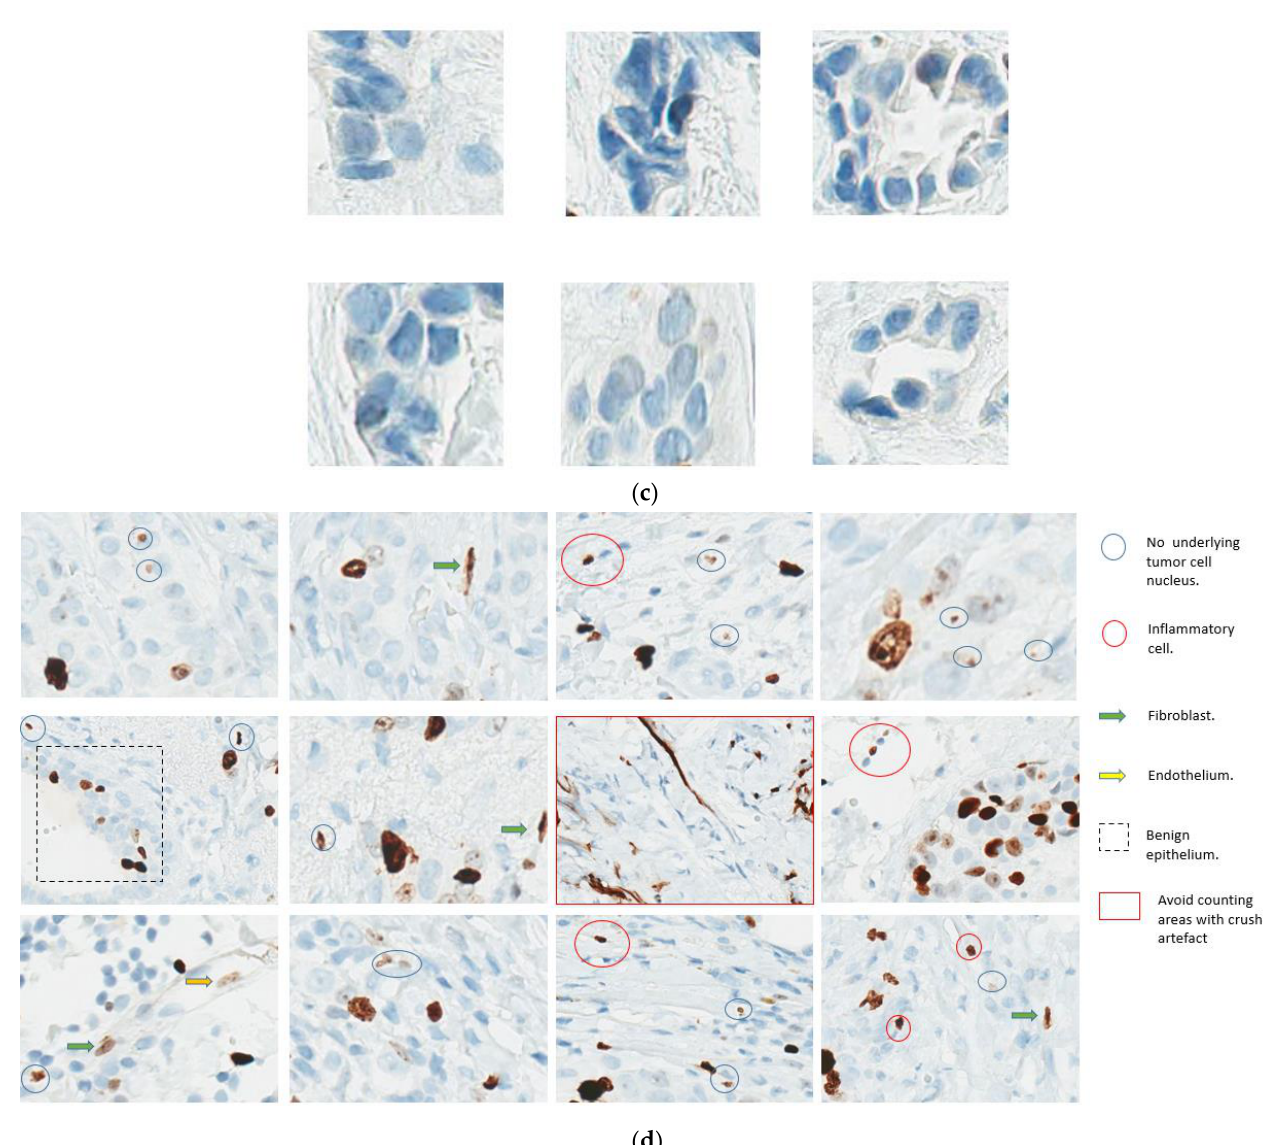
Figure 4. ( a ) . Ki67 Positive nuclei; ( b ): Ki67 Light brown positive nuclei; ( c ): Ki67 Negative nuclei. ( d ): Don’t count these. ( a,b ) illustrate the spectrum of Ki67-positive nuclei. As per IKWG, any staining above the background is considered positive. ( c ) Illustrates Ki67 negative nuclei. Figure ( d ). Illustrates what not to count when counting Ki67.